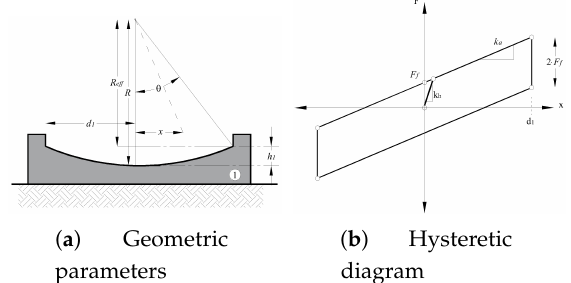
Figure 2. Concave plate geometry and simplified hysteretic diagram. R : Radius of the isolator. h 1 : height from the inner edge of the plate. R ef f : Effective radius ( R − h 1 ). d 1 : Displacement